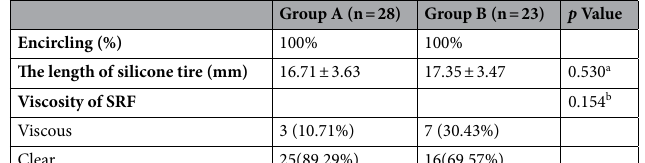
defined as 2 quadrants, the extent between 6 to 9 clocks was defined as 3 quadrants, and the extent between 9 to 12 clocks was defined as 4 quadrants. The grade of PVR was determined according to the classification from the American Retina Terminology Committee (1983).